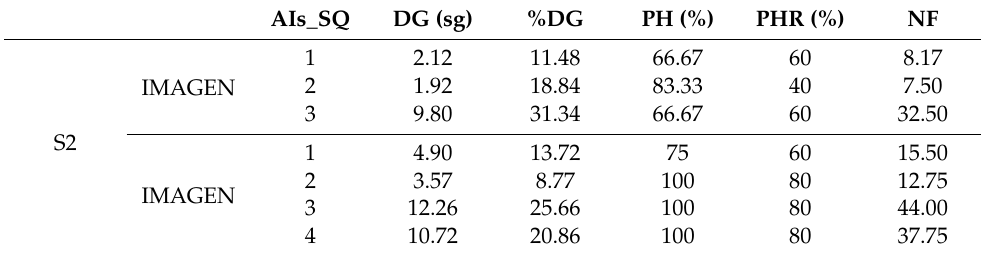
Table 2. Fixations and gaze by AOI for S2.